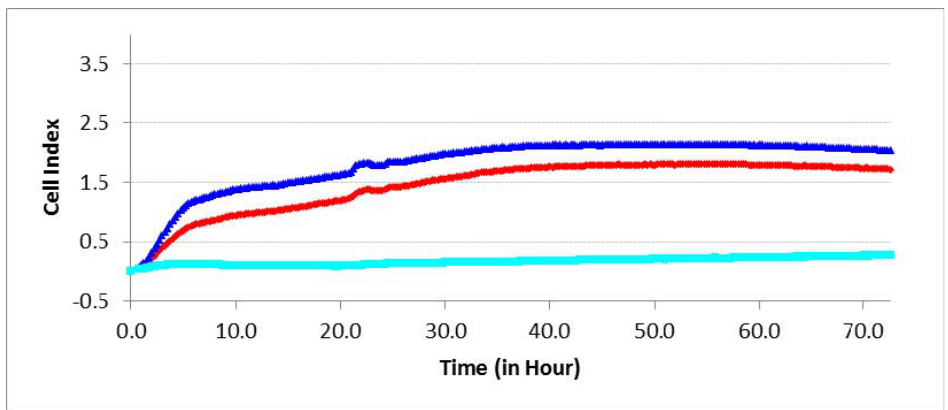
Figure 8. Experimental curves of impedance in the real-time cell analyzer (RTCA) system mirror the migration index (MI) of different cells passing through the microporous membrane. hAMSC invasion towards hBMNCs (top blue line), and vice versa (bottom cyan line); control hAMSC motility towards cell-free nutrient medium (middle red line).